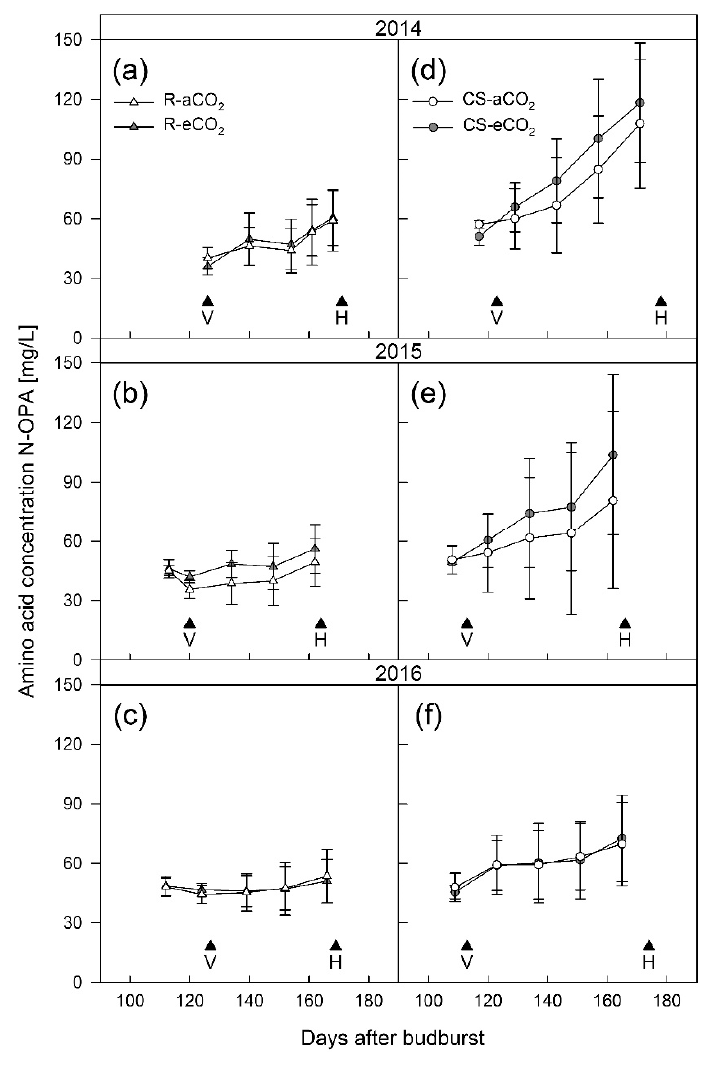
Figure 7. Amino acid concentration during ripening periods of the three seasons 2014, 2015, and 2016 for the two varieties Riesling ( a – c ) and Cabernet Sauvignon ( d – f ) and the two treatments aCO 2 and eCO 2 . Letters indicate seasonal development stages veraison (V) and harvest (H). Mean values per treatment ± SD of the three FACE rings.